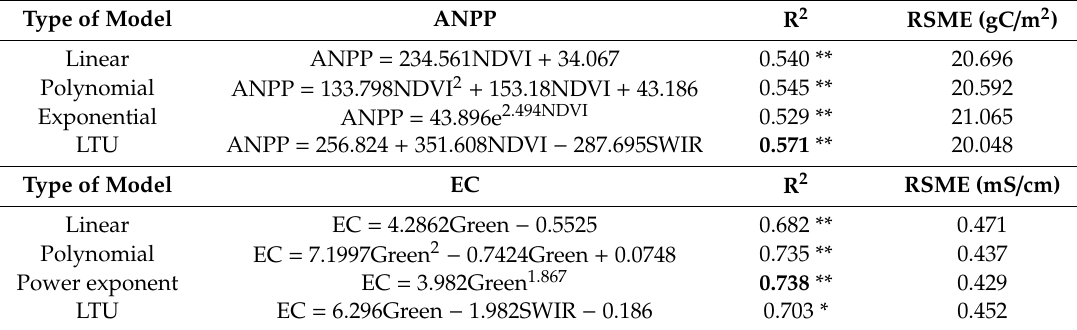
Table 2. The model comparisons of grassland degradation parameters.